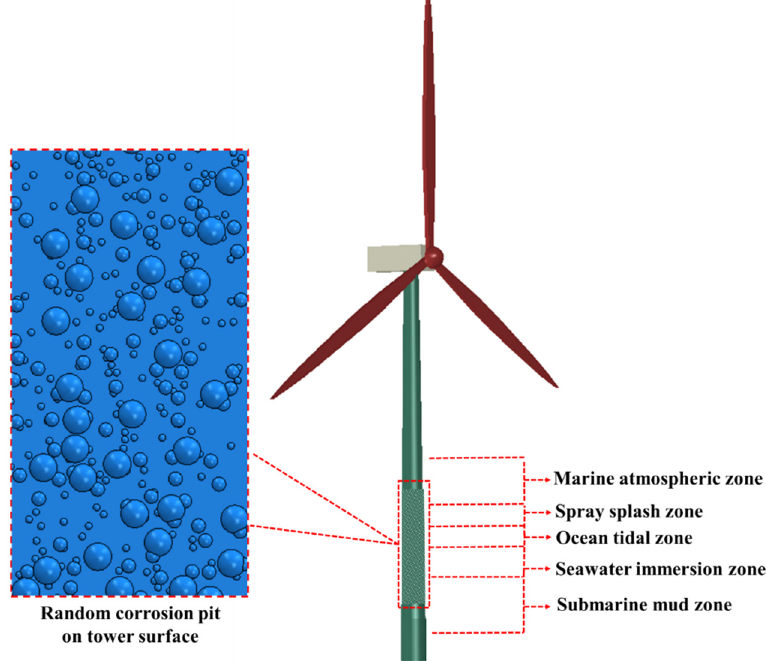
Figure 5. FE model with random corrosion.